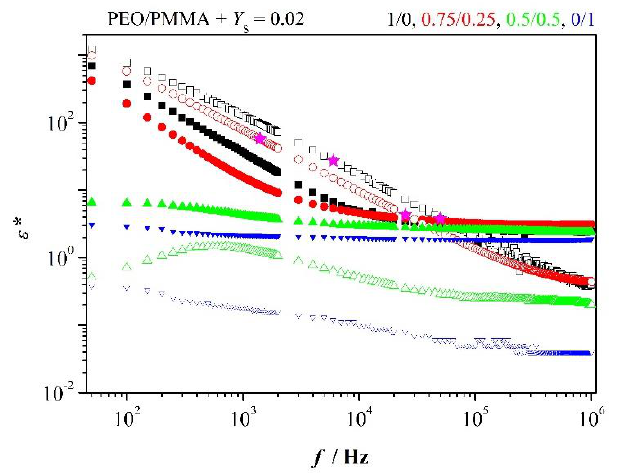
Figure 7. Permittivity spectra for the indicated blends and salt content; stars manifest range (6). ’ – solid marker; relevant data for the blends 1/0 and 0.75/0.25: f + = 2.2 × 10 5 Hz, n = 0.92, dc = 9.4 × 10 -6 A/(V m); f + = 1.3 × 10 5 Hz, n = 0.90, dc = 5.5 × 10 −6 A/(V m)